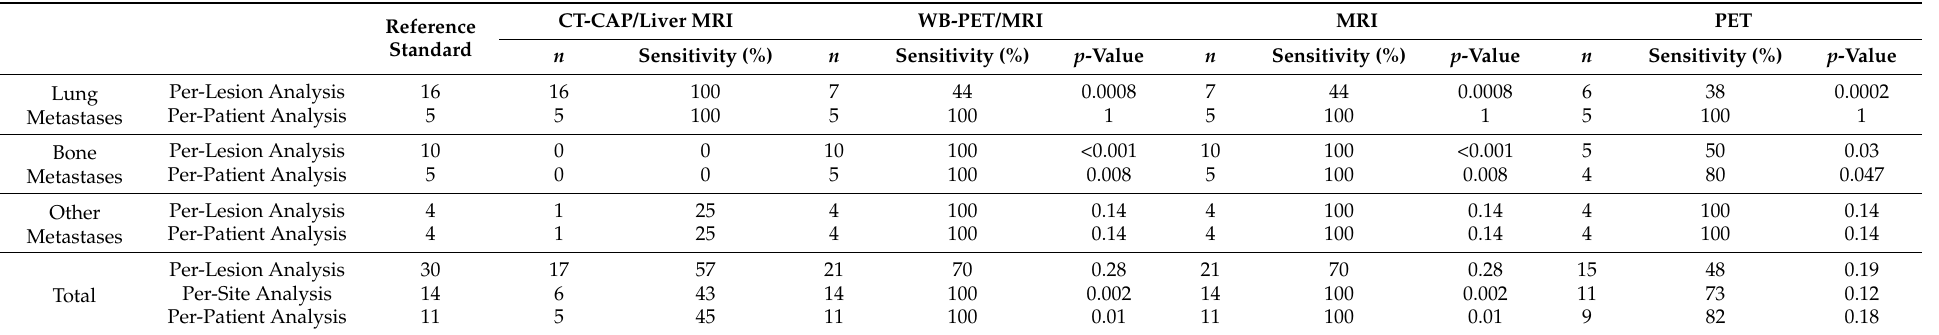
Table 2. Per-lesion, per site, and per-patient sensitivities of the CT-CAP/liver MRI combination, WB-PET/MRI, MRI, and PET for distant metastases detection according to their